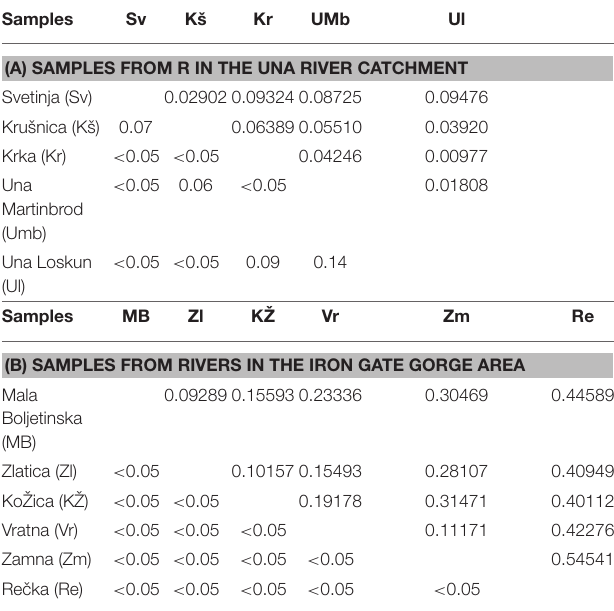
( Figure 3 , top): the first one consisting of brown trout from the Svetinja and Krušnica Rivers, and the second one of brown trout from the Krka River and upper Una River (localities Martinbrod and Loskun).